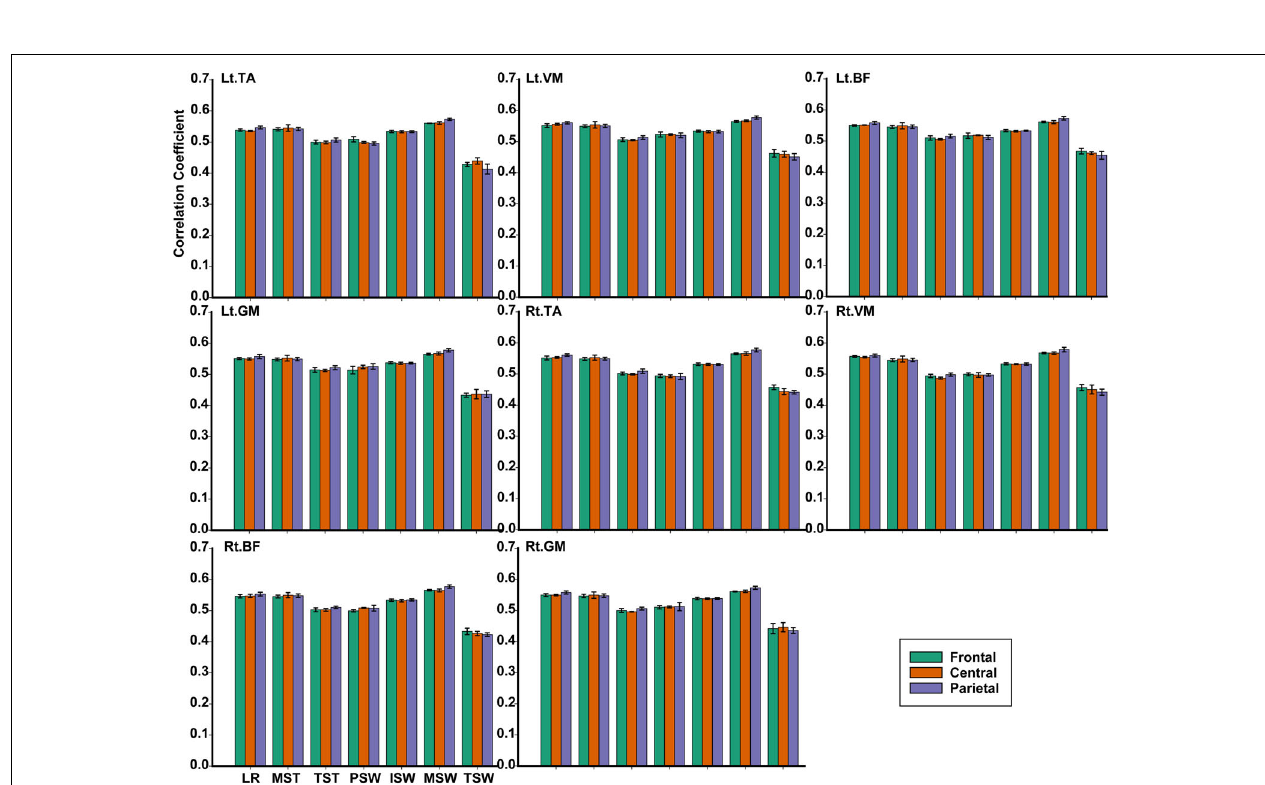
FIGURE 9 | The TFCMI values of the frontal, central, and parietal lobes in seven gait phases for eight muscles.